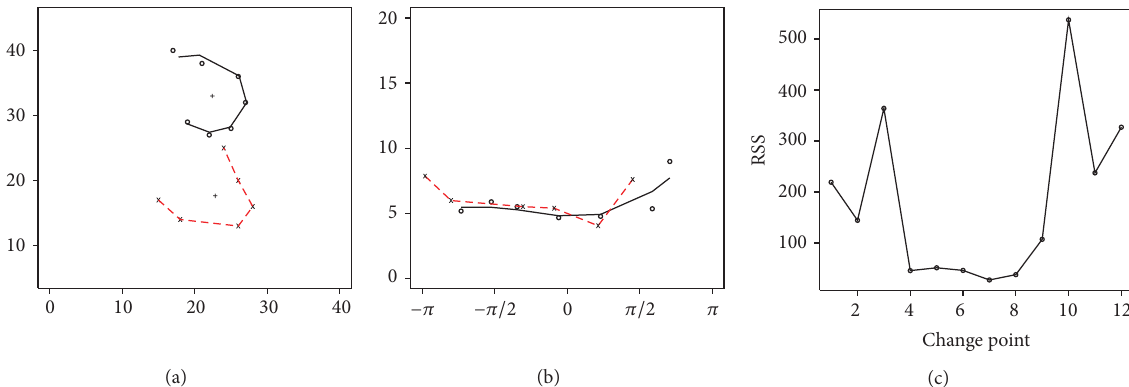
Figure 9: (a) A typical number 3 dataset along with the back-transformed fitted two-part spline; (b) points in polar coordinates and two-part spline curve; (c) RSS plotted against change point position.